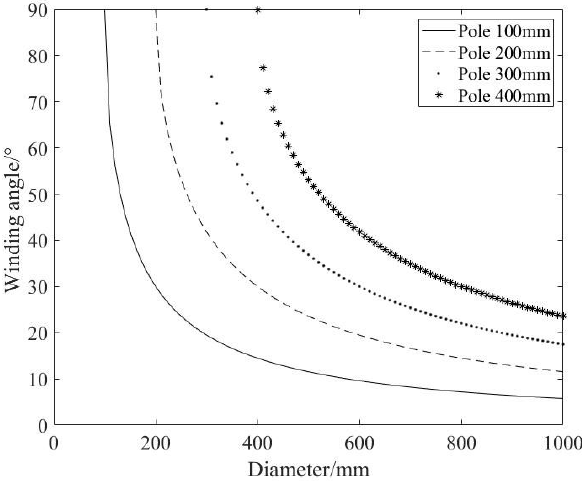
Figure 6: Winding angles of geodesic trajectories with different poles